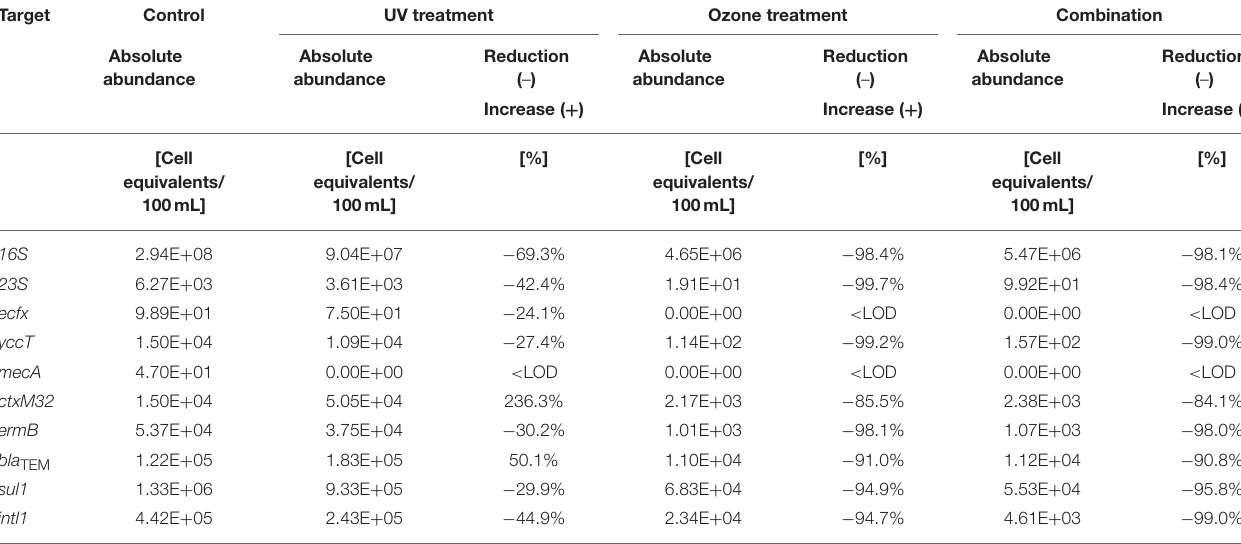
TABLE 2 | Reduction efficiencies of advanced wastewater treatment technologies on taxonomic and antibiotic resistance gene markers. Target